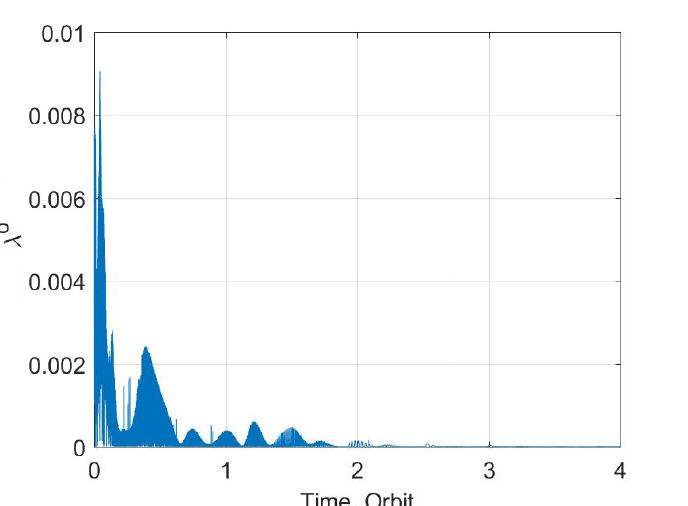
Figure 5. The angle λ , in degrees, between the actual torque T and the estimated torque ˜ T using the five-point stencil method for computing ˙ ω